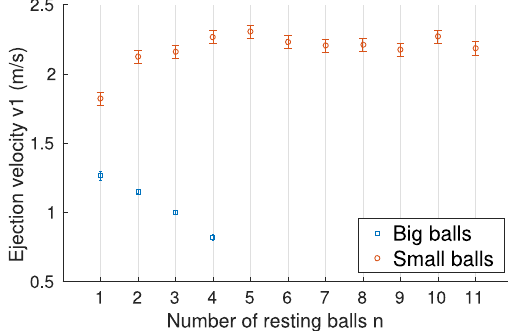
Fig. 6. Ejection velocities v 1 for balls of various sizes when v 0 =0, as a function of the number of balls in-between the magnet and the ejected ball n . n =0 is left out, as no ejection occurs. For small balls, n =5 is optimal. For big balls, its n =1, the smallest possible n .